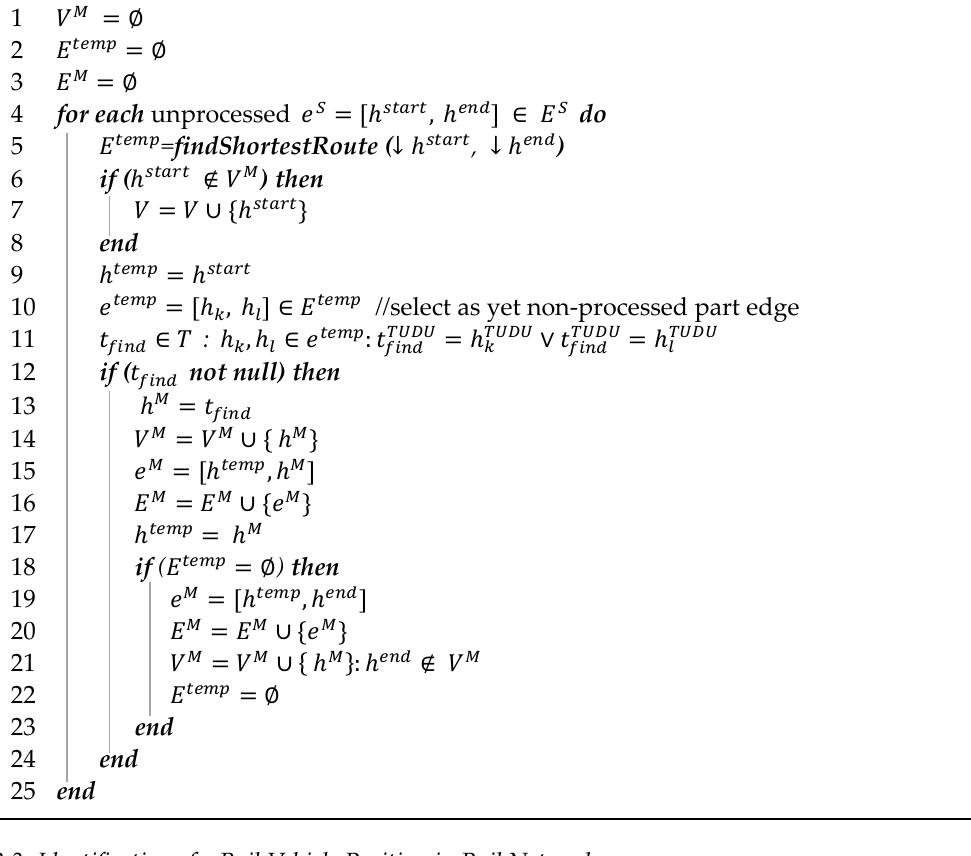
Algorithm 5: Algorithm concept of data-meso model layer construction. Algorithm 5. Algorithm concept of data-meso model layer construction.